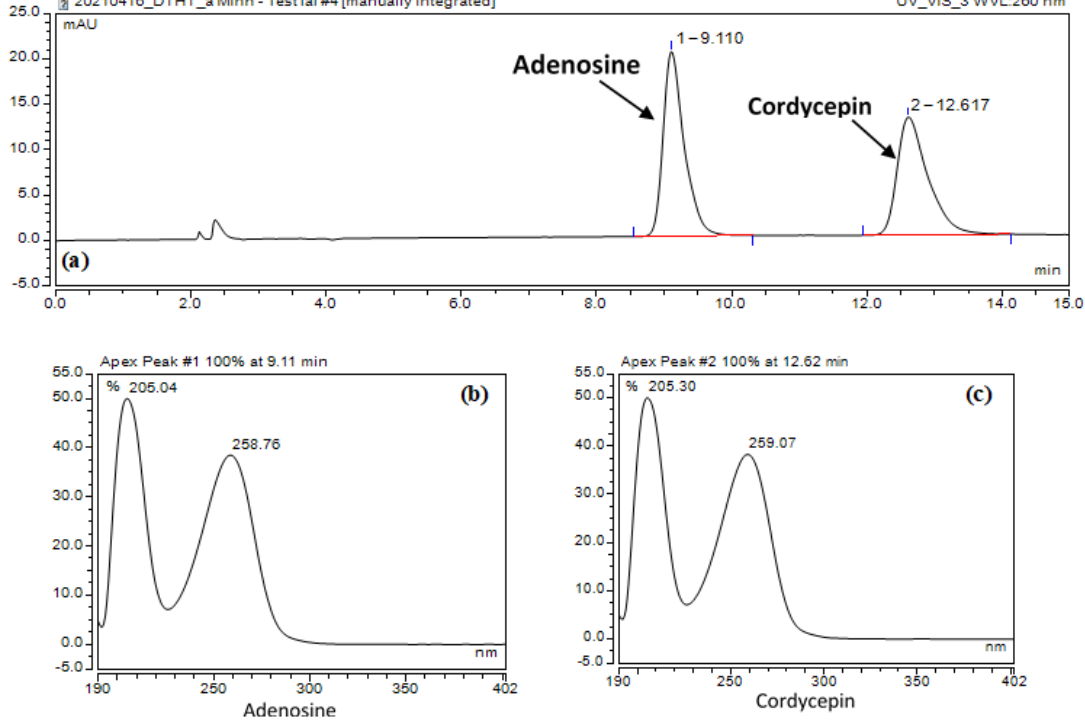
Figure 2. Chromatogram of Cor, Ado ( a ) and their ultraviolet-visible spectrophotometry ( b , c )